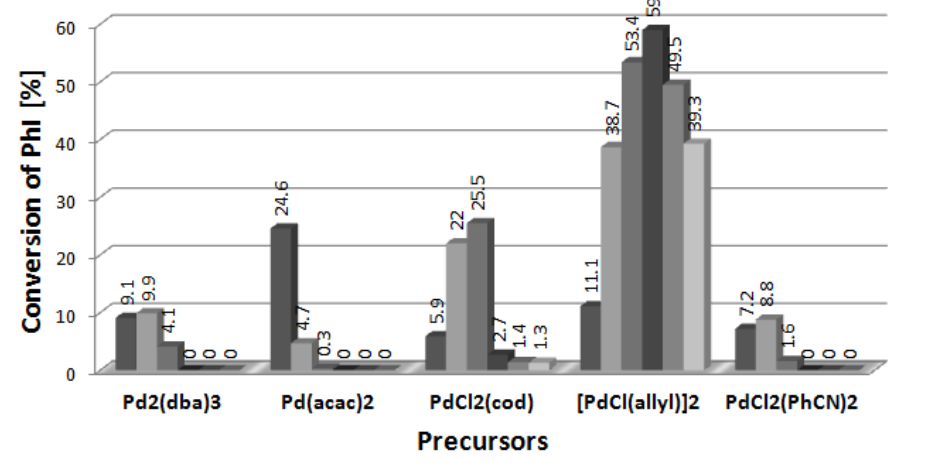
Figure 4. Effect of [CIL]:[Pd] ratio on conversion of PhI in Heck arylation of DHF. CIL = [Bu 4